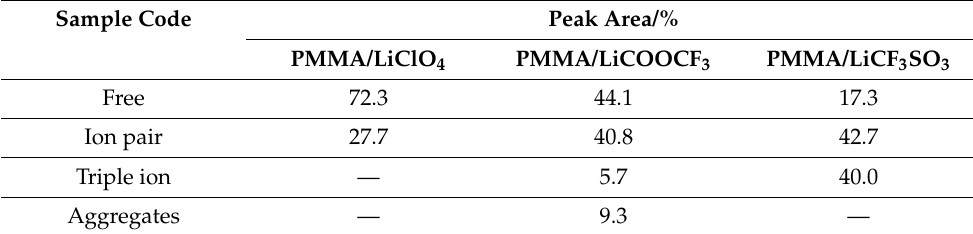
Table 2. The contribution ratios of the structures of anionic species (ClO 4 − , CF 3 SO 3 − , and COOCF 3 − ) calculated using the area ratios of the ATR spectra peaks [22]. Their concentrations of lithium salts are [Li]/[C=O] = 0.07. Sample Code Peak Area/% PMMA/LiClO